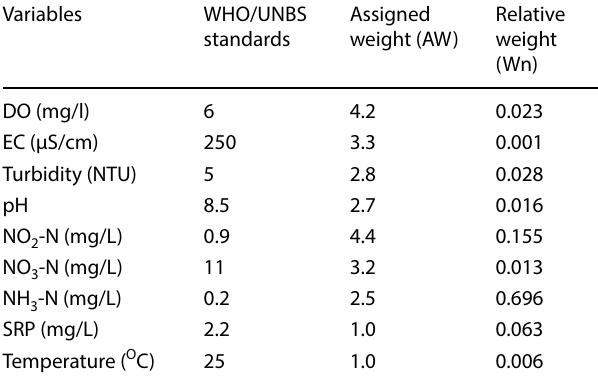
** Correlation is significant at the 0.01 level (2-tailed) * Correlation is significant at the 0.05 level